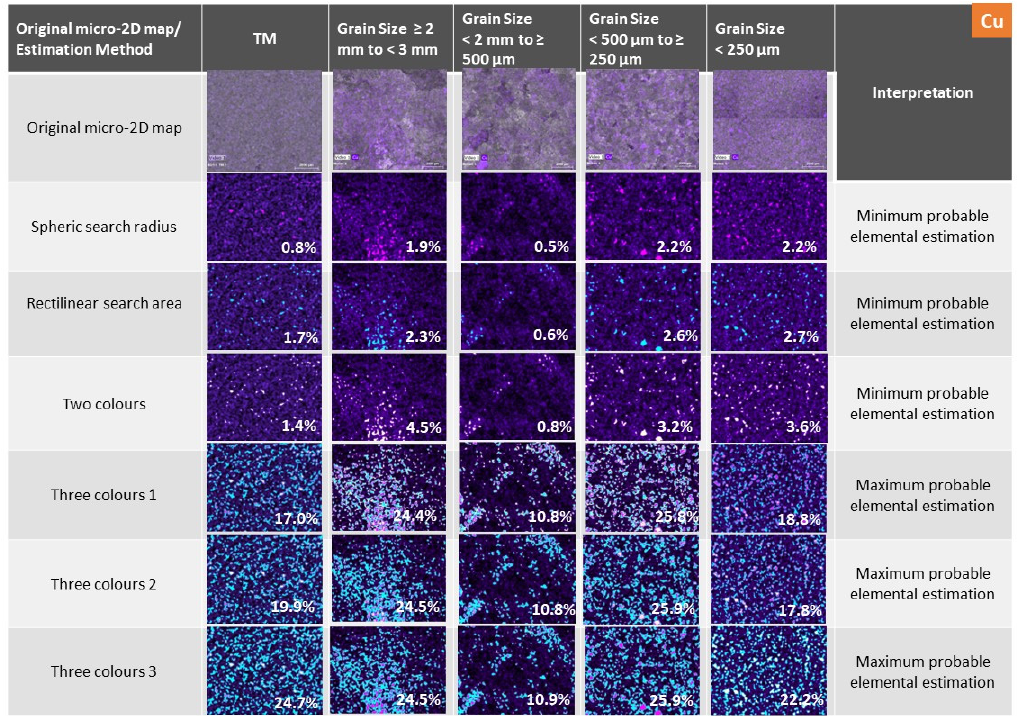
Figure A2. Minimum and maximum probable elemental occurrence in µ-XRF 2D map (percentage of area %) for Mn.